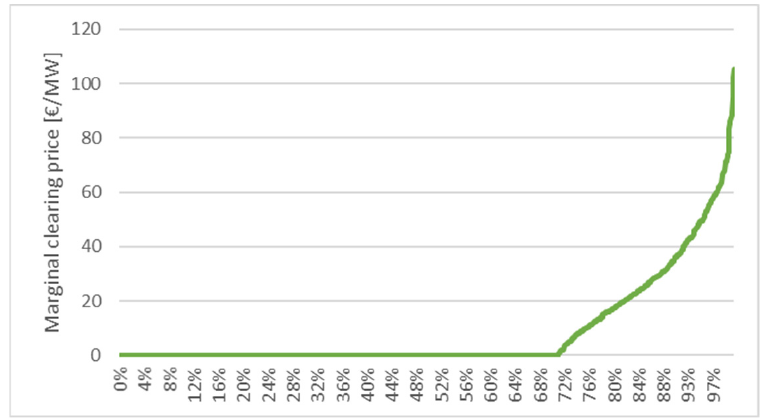
Figure 10. Duration curve of Sicily marginal clearing price. The RR auction results are in Figure 11: